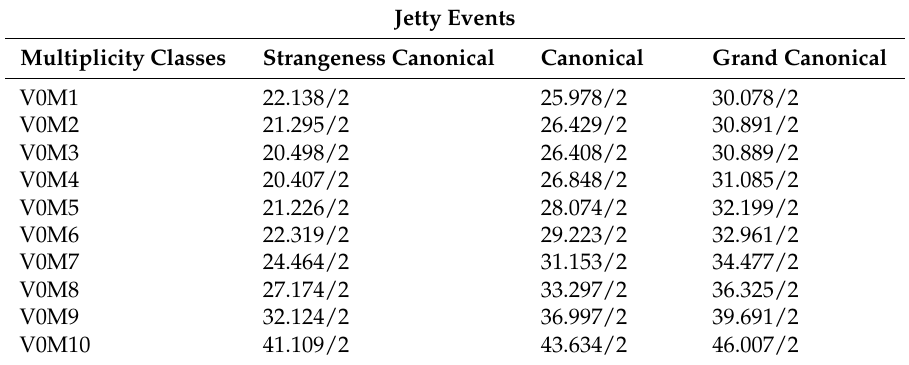
Table 3. χ 2 /NDF of the fits for jetty events in different multiplicity classes for pp collisions at